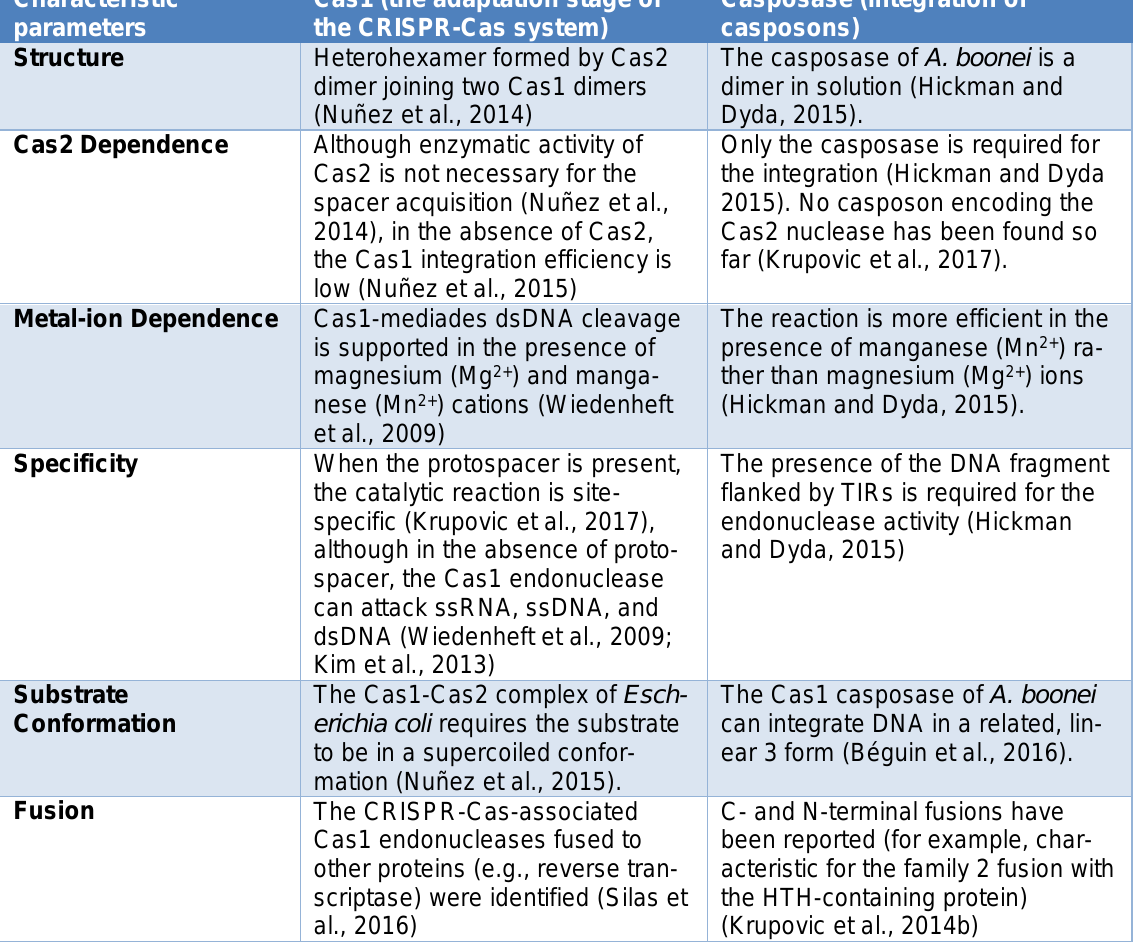
Table 1: The comparative analysis of the casposases and the CRISPR-Cas1 nucleases